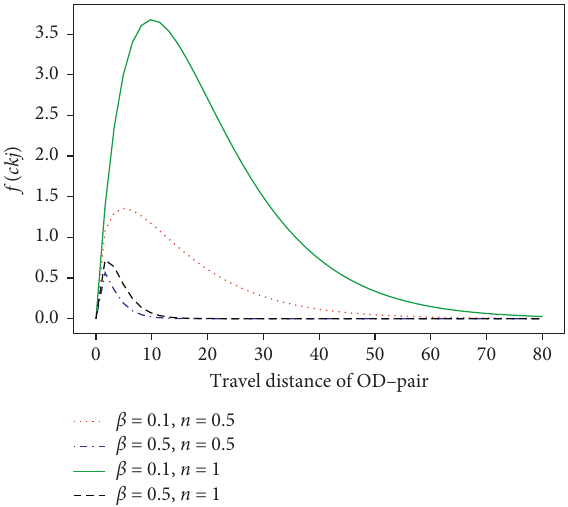
Figure 5: Cost functions with different